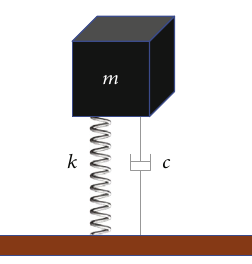
Figure 1: Vibration model of single-degree-of-freedom